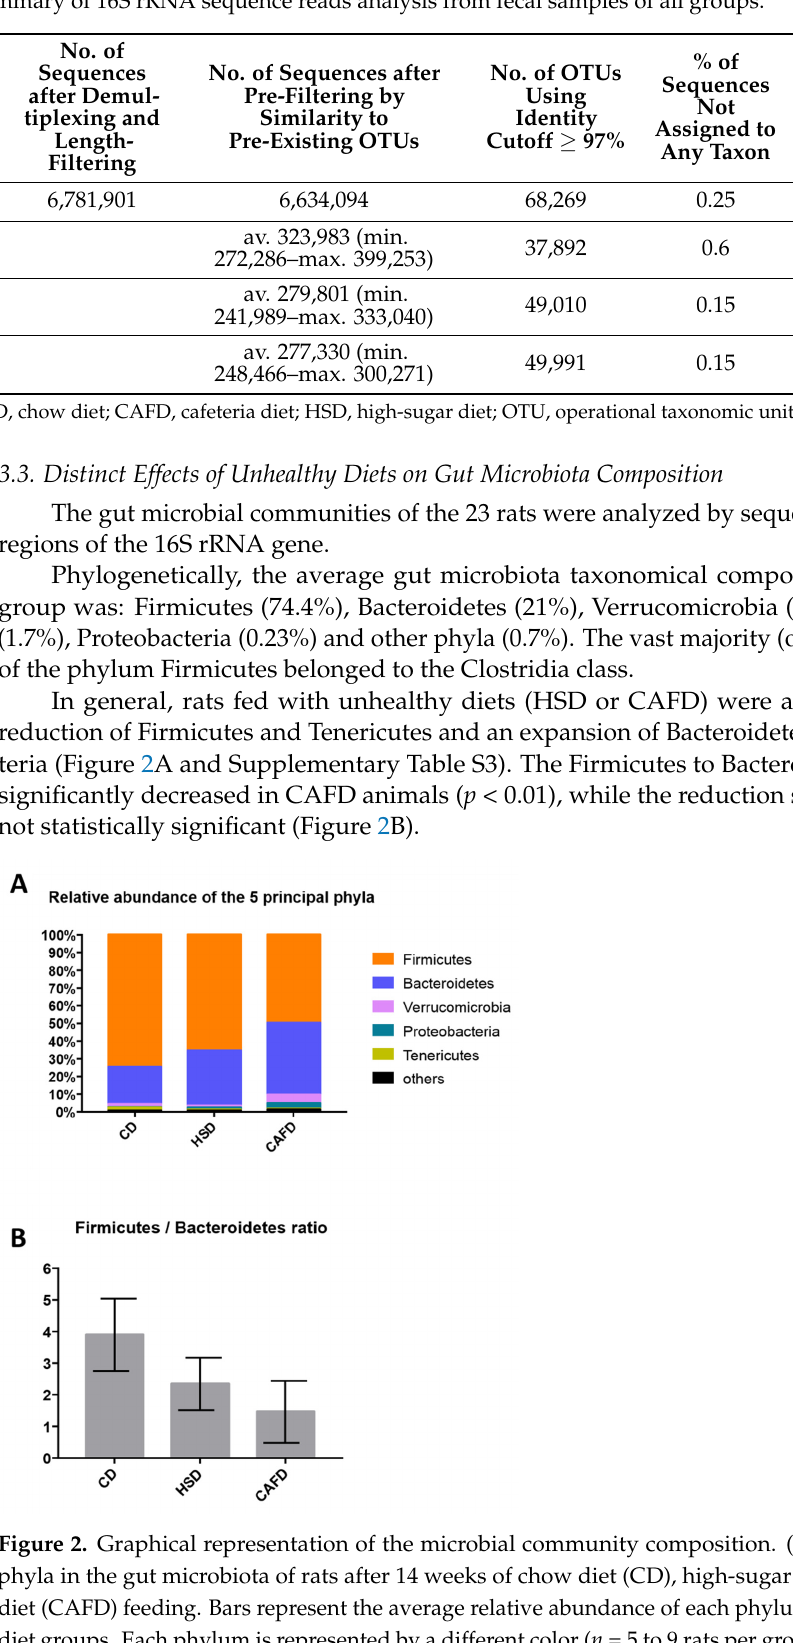
Table 2. Summary of 16S rRNA sequence reads analysis from fecal samples of all groups.